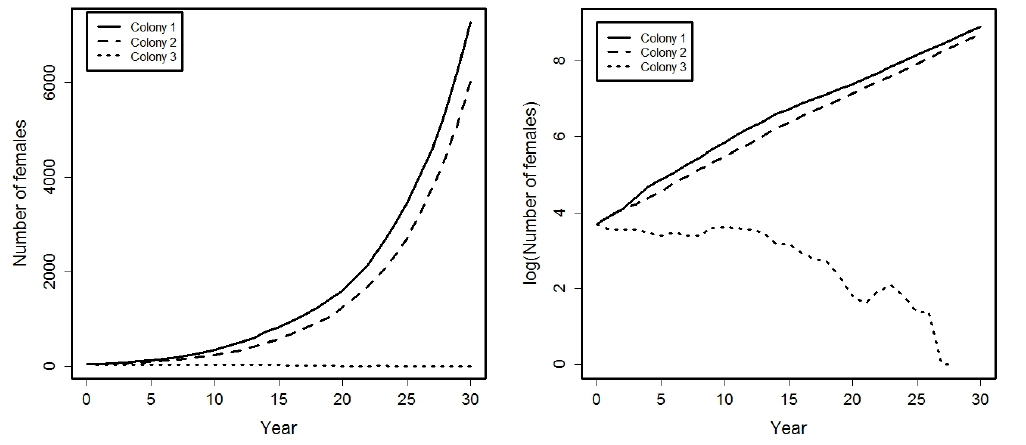
Figure 2. Evolution, during a period of 30 years, of the total number of females in each colony ( left graphic ) and its corresponding logarithms ( right graphic